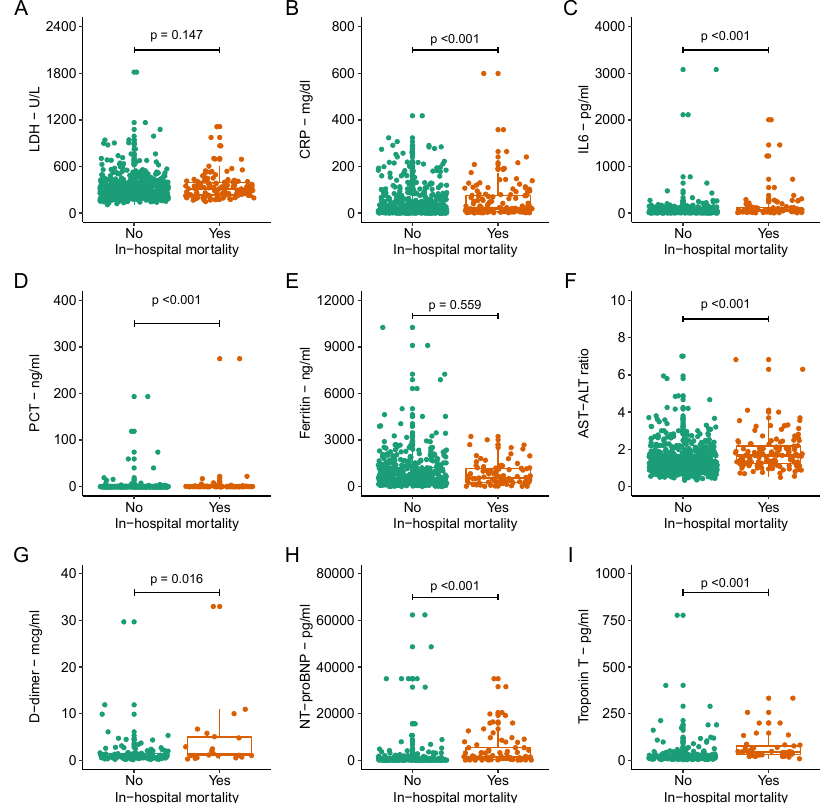
Figure 1. Distribution of biomarkers by in-hospital mortality. Each subplot ( A – I ) compares the distribution of biomarker between patients who died in the hospital and those who survived. Y-axis represents the range of values for each biomarker and X-axis represents patients who died versus those who were alive. LDH: lactate dehydrogenase; CRP: C-reactive protein; IL6: interleukin 6; PCT: procalcitonin; AST: aspartate aminotransferase; ALT: alanine aminotransferase; NT-proBNP: N-terminal pro-brain natriuretic peptide. p = Wilcoxon rank-sum test p -value.